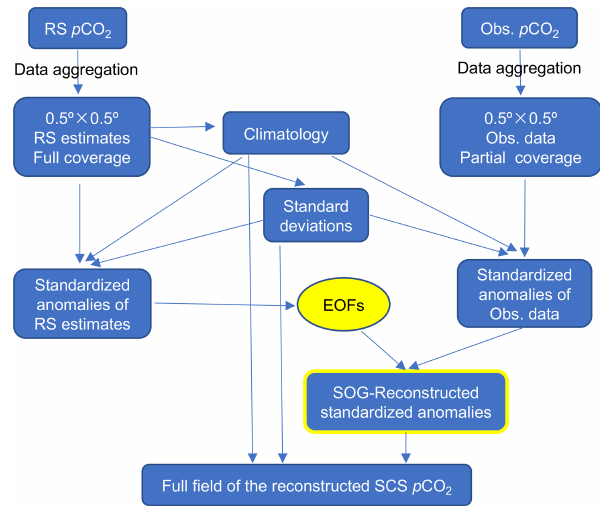
Figure 1. Reconstruction procedure of the sea surface p CO 2 in the SCS. Here, RS p CO 2 means the original remote-sensing- derived p CO 2 ; Obs. p CO 2 represents the original observed in situ p CO 2 . RS estimates are the grid-aggregated remote-sensing- derived p CO 2 , and Obs. data are the grid-aggregated observed p CO 2 . The standard deviations are the temporal standard deviation of the RS p CO 2 estimates on each grid